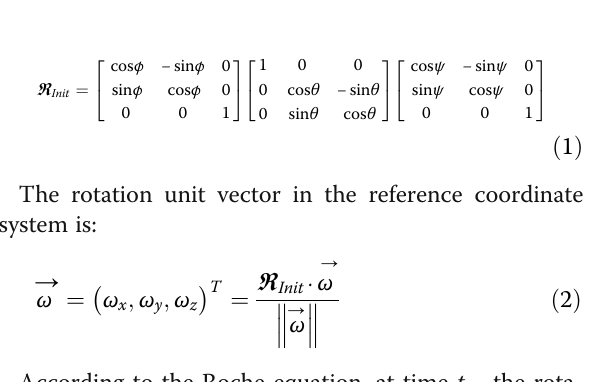
Fig. 1 The geometric representation of micro-spin